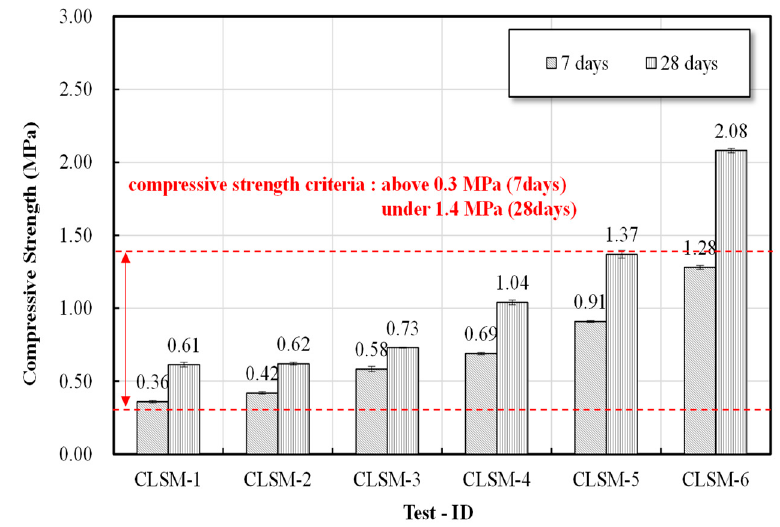
Figure 5. Compressive strength test results by age with respect to the W/B.